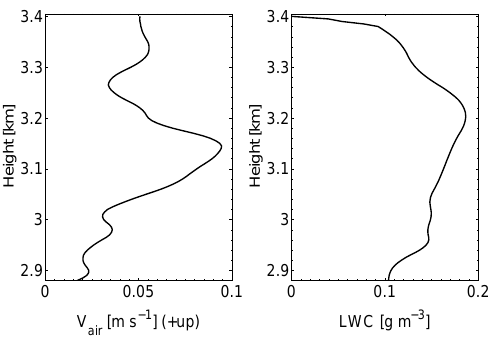
Figure 10. Mean vertical air motion profile ( V air , left) derived from liquid-mode mean Doppler velocity and liquid water content (LWC, right) derived from liquid peak reflectivity between the two black fall streaks in Fig. 5,